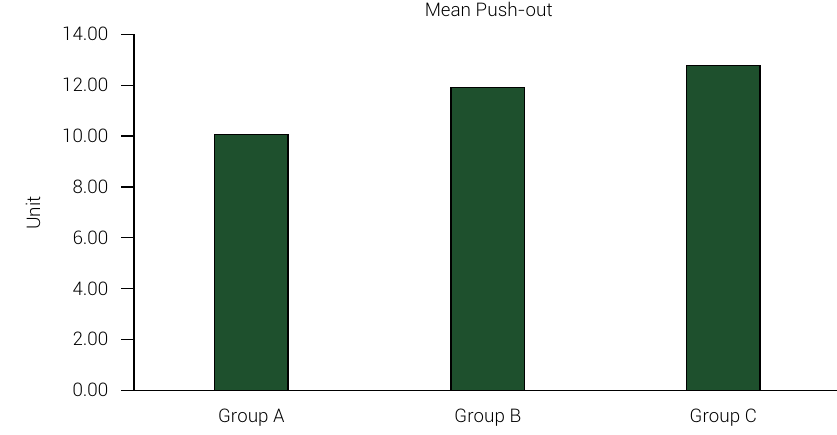
Figure 5. Bar chart representing the mean push-out in the apical third in the three